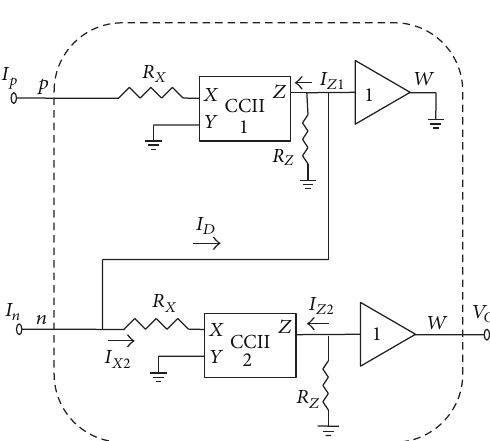
F 5: OTRA constructed with AD844.